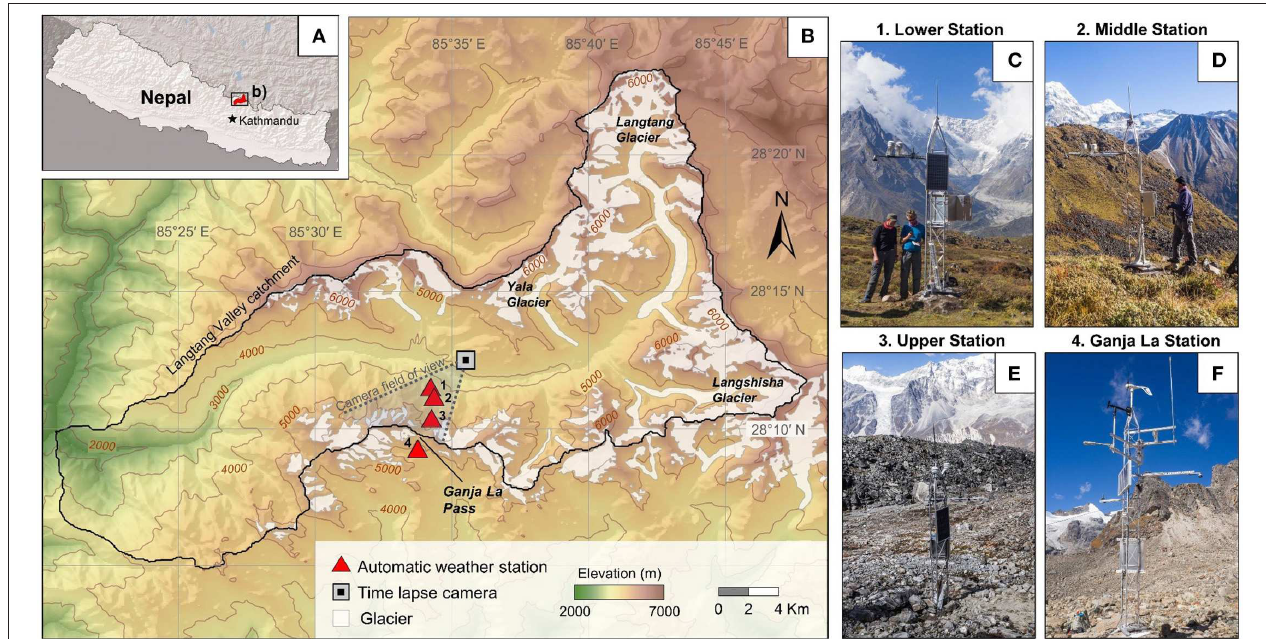
FIGURE 1 | Study site location. (A) The location of Langtang Valley, Nepal. (B) Automatic weather station and time lapse camera location within the Langtang Valley catchment. Major glaciers and ice masses in Nepal are displayed ( Bajracharya et al., 2014). The lower (C) , middle (D) , upper (E) , and Ganja La (F) automatic weather stations in snow free conditions.